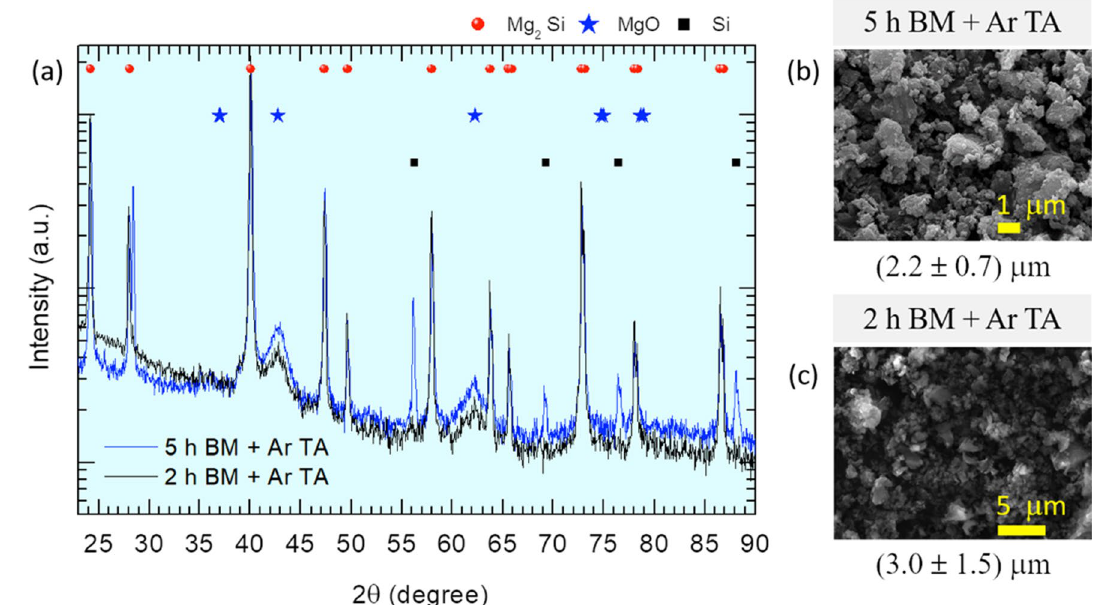
Fig. 4 XRD diffratograms ( a ) of Si–Mg powders ball milled (BM) for 2 h (black line) and 5 h (blue line) and next thermally annealed in Ar. The SEM micrographs after the synthesis sequences are also